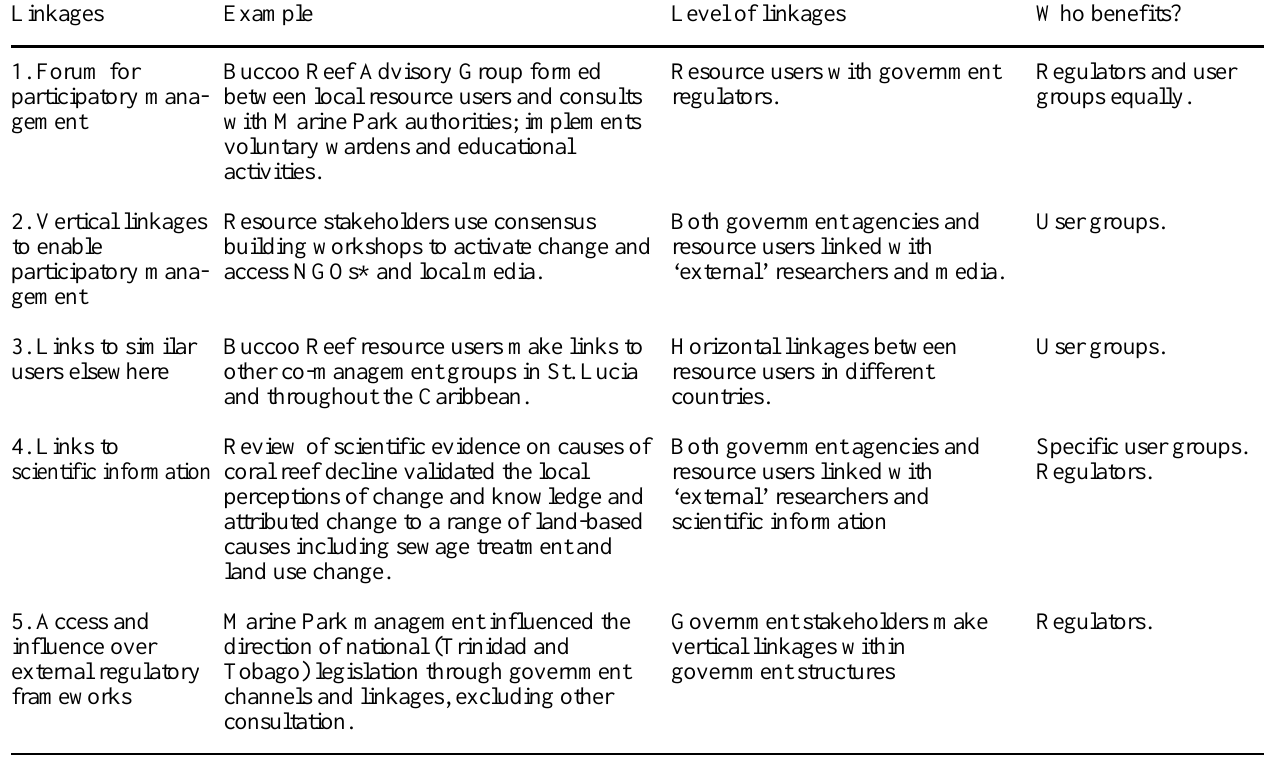
Table 2 . Differential benefits of cross-scale linkages in Buccoo Reef Marine